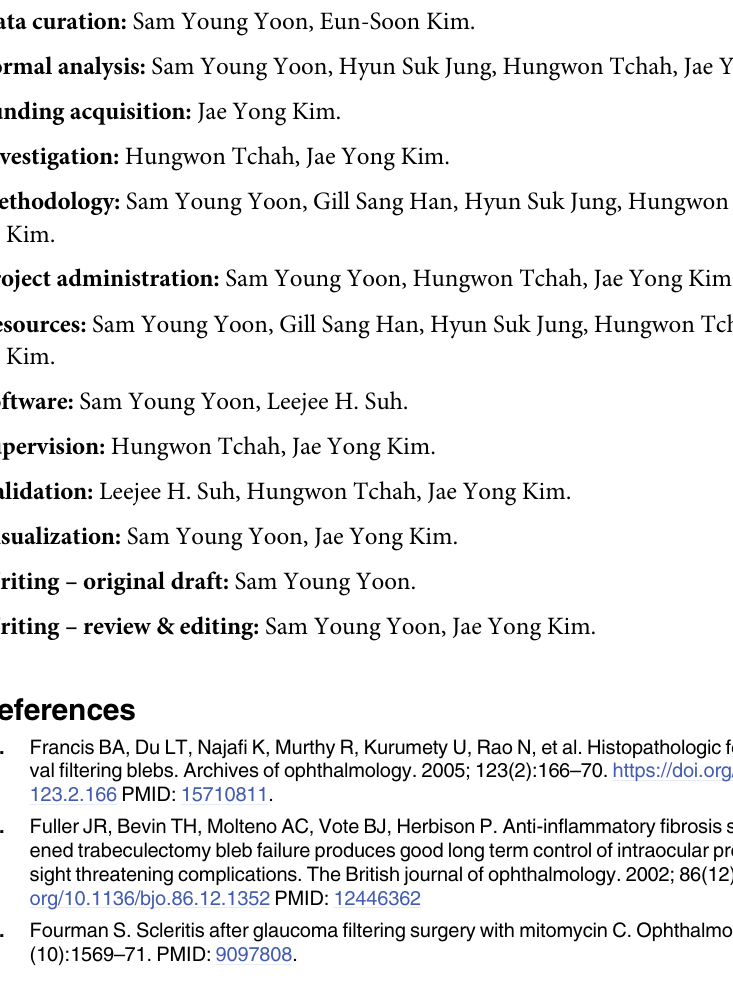
S2 Fig. Paracentral corneal opacity of the mitomycin C group. S1 Table. Histologic data of four groups. S1 Dataset. Dataset containing the scores of conjunctival congestion and histologic data of four groups.